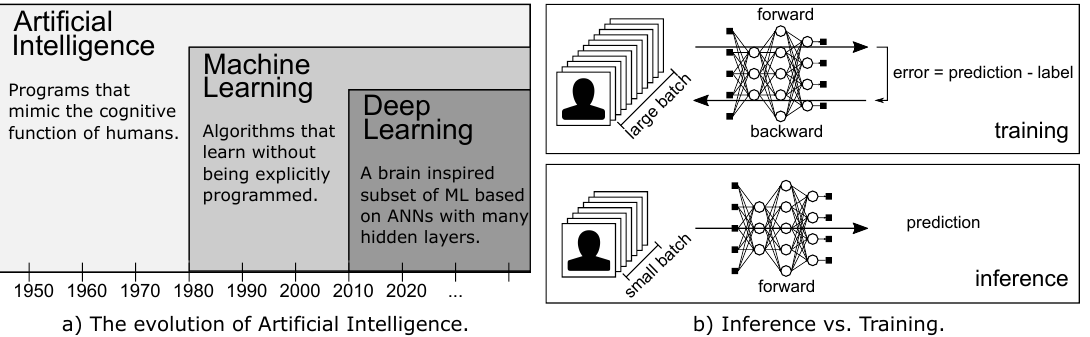
Figure 1. ( a ) How artificial intelligence has evolved over the years. ( b ) The processes of training and inference in